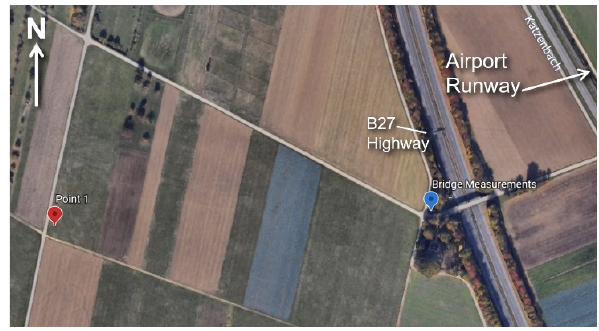
Figure 24. Highway measurement location near bridge.